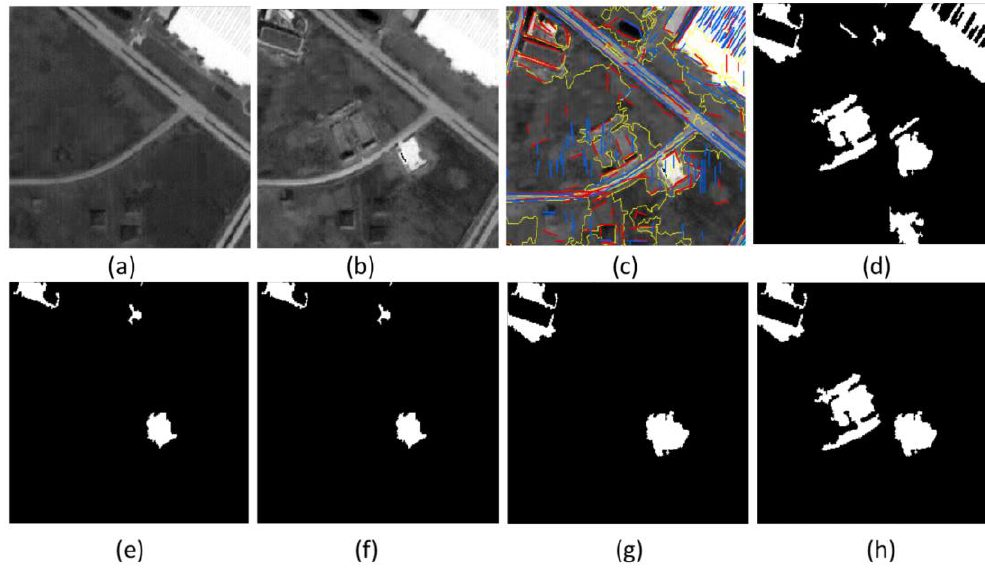
Figure 8. Enlarged area 1. ( a , b ) Original images. ( c ) TRPs and TLPs. ( d ) Result of CVA. ( e ) Result of PCA-k-means. ( f ) Result of IRMAD. ( g ) Result of initial detection. ( h ) Result after refinement.